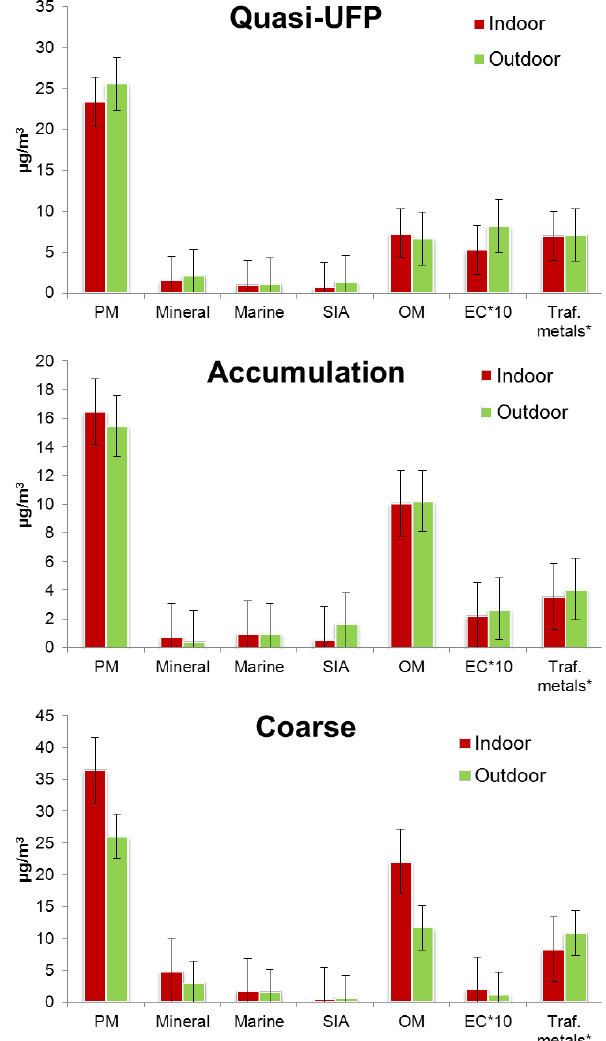
Fig. 2. Mean indoor and outdoor relationships for PM mass, the main aerosol components (mineral matter; secondary inorganic aerosols, SIA; marine aerosol; organic matter, OM; elemental carbon, EC) and traffic-related metals (Sn, Sb, Cu, Rivas et al., 2013) in the coarse, accumulation and quasi-ultrafine modes. * in ngm − 3